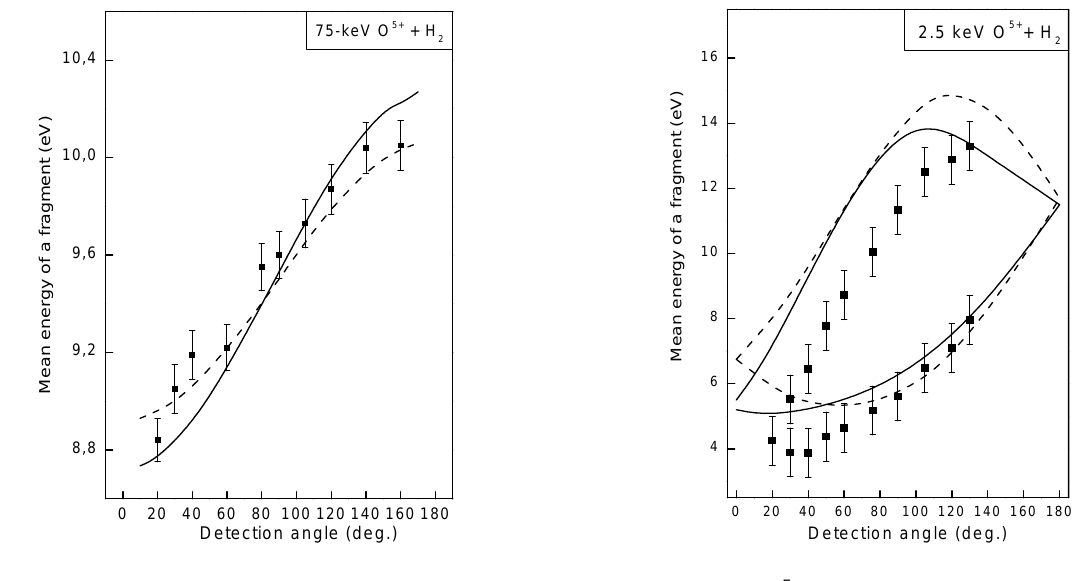
Figure 9. Maximum of fragment energy distribution following O 2.5 keV. Full squares, experimental values; dashes curves, TS2B calculations; solid curves, OS3B